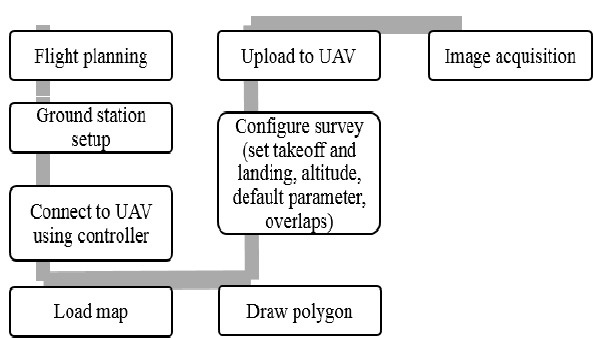
Figure 6. Flight Map in DJI Go Application